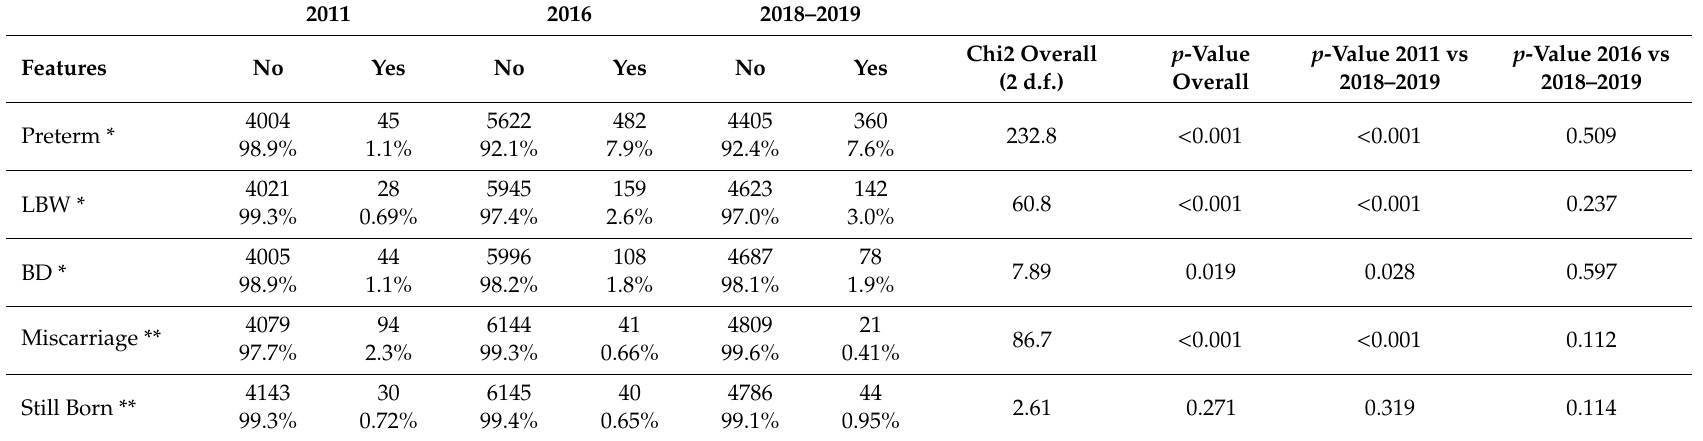
Table 2. Prevalence of outcomes at birth in the years 2011, 2016 and